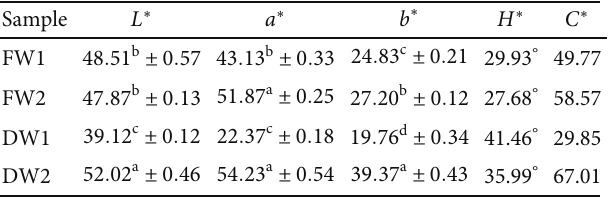
Table 4: Chromatic characteristics of wine in CIELab colour space.